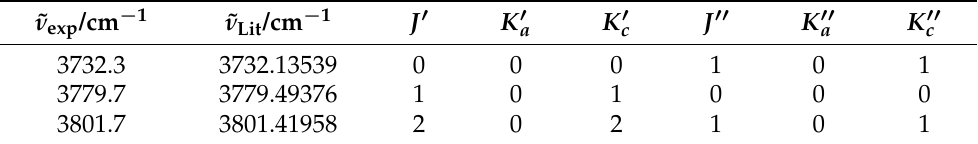
Table 3. Assignment of the observed (˜ ν exp ) water lines [86] to literature values (˜ ν Lit ) and their respective rovibrational transitions (Ref. [88]). In all cases, the vibrational transition involved is the asymmetric OH stretch fundamental. J (cid:48) , K (cid:48) a , K (cid:48) c , and J (cid:48)(cid:48) , K (cid:48)(cid:48) a , K (cid:48)(cid:48) c are the rotational quantum numbers of the excited and ground vibrational state, respectively. The 0.2(1) cm − 1 deviation from the literature line positions indicates a slight calibration error of the reference laser.